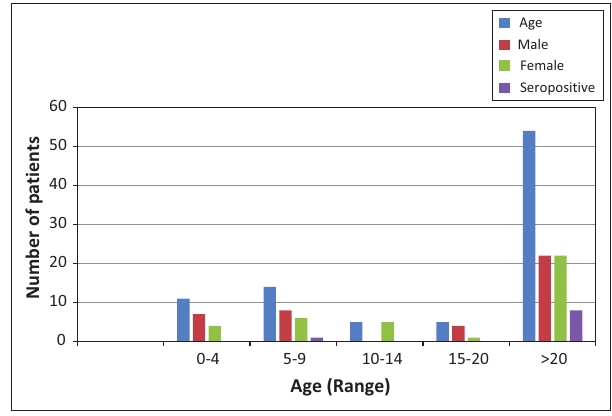
FIGURE 2: Transfused cancer patients by age, sex and seropositivity at Kenyatta National Hospital, Nairobi, Kenya,